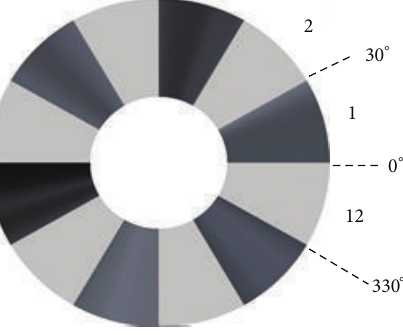
Figure 5: Divided